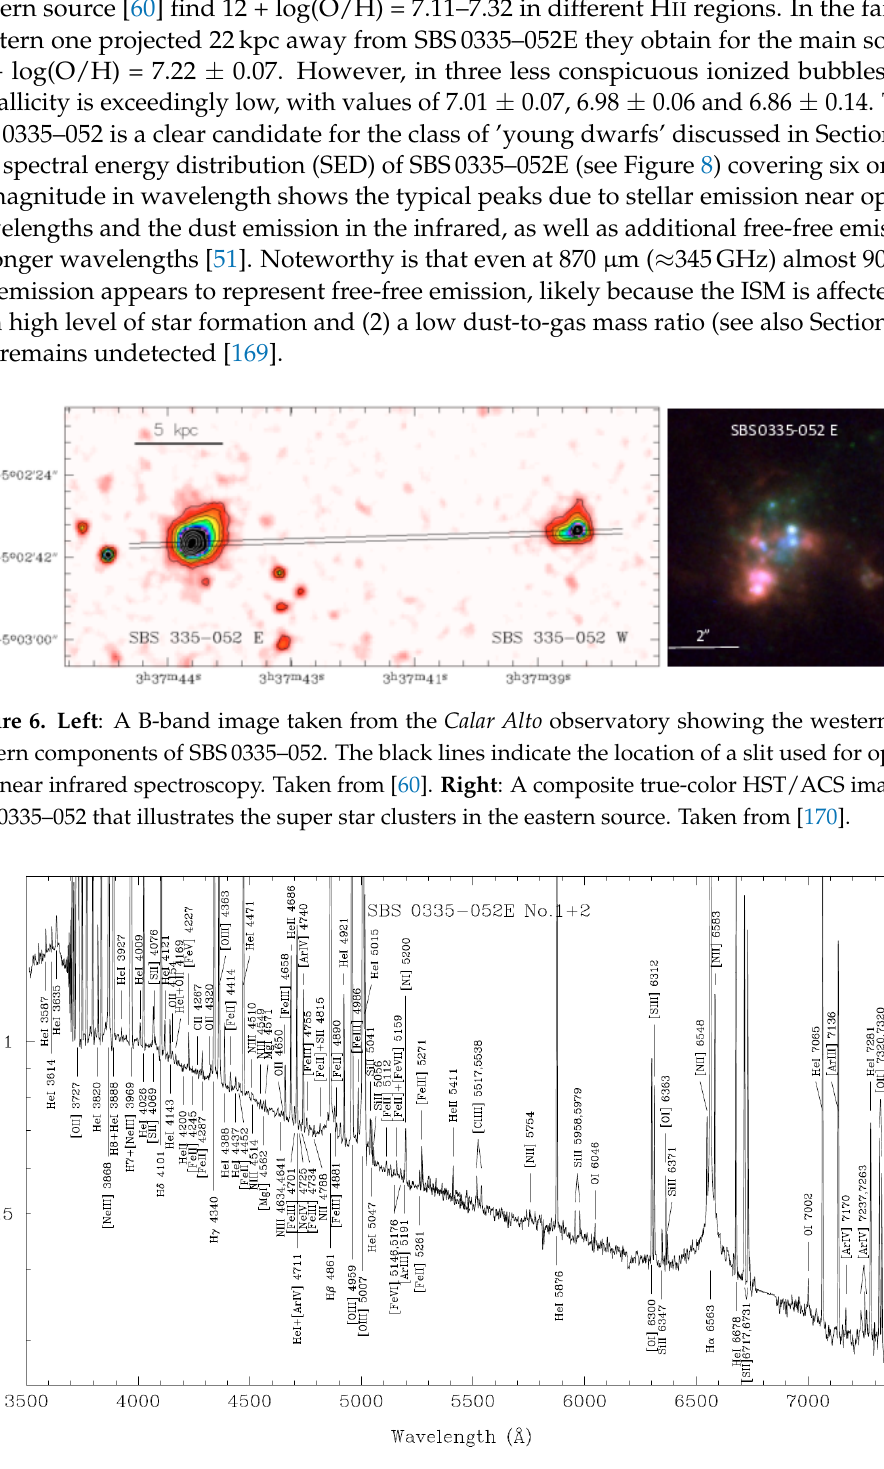
Figure 7. A FORS high-resolution spectrum taken with the Very Large Telescope (VLT) of the European Southern Observatory (ESO) from the two southern SSCs of SBS0335-0052 (see Figure 6, right panel), employed to derive metallicities. The spectrum, showing particularly wide hydrogen recombination lines, was published by